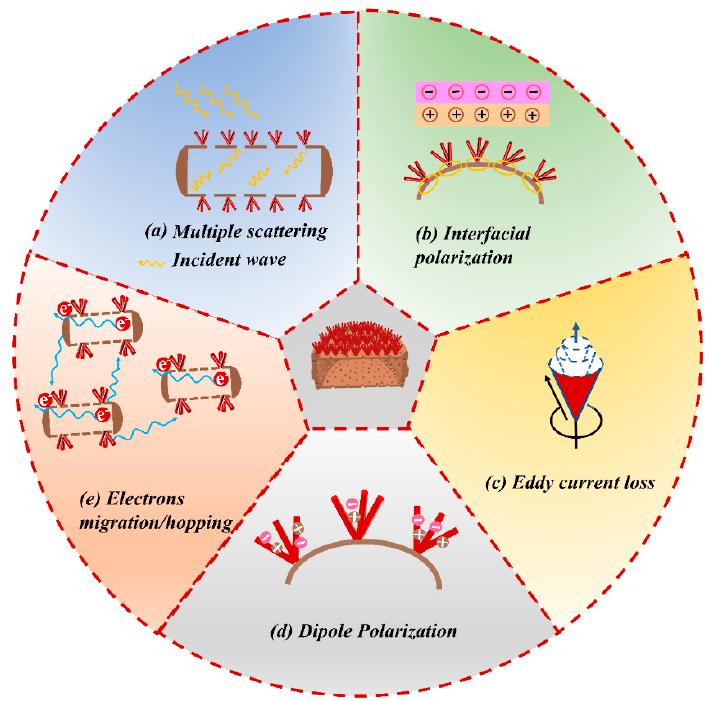
Figure 5. Microwave absorption mechanism of α -Fe 2 O 3 @D composite materials.